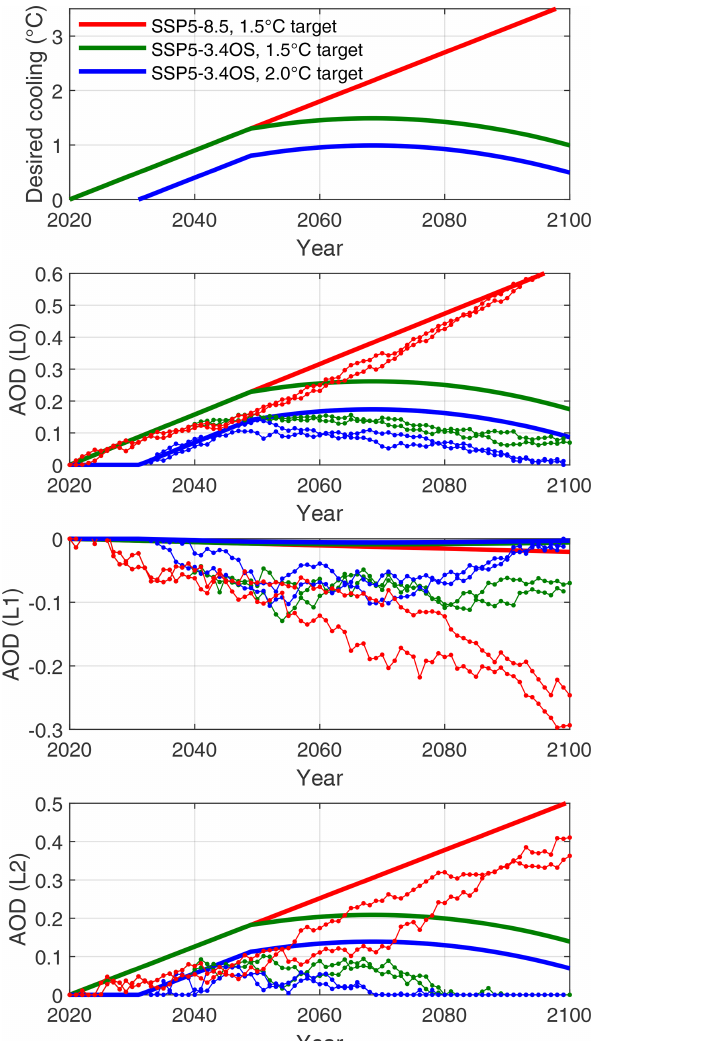
Figure A1. Feedforward used in simulations. Top panel shows the fit to the desired temperature reduction for different cases (see text for details). Remaining panels show both the feedforward (best guess for desired AOD prior to conducting the simulation) and actual AOD after feedback correction (dotted lines) for the global mean AOD (L0), the projection of the AOD onto sin(lat) (the interhemispheric gradient L1), and the projection onto a quadratic (the Equator-to-pole gradient L2). There is substantial error in the initial guess, due to a combination of uncertainty, nonlinearity, and making the feedforward in a given year only proportional to the desired temperature reduction in that year; this illustrates the importance of using a feedback algorithm to correct these initial